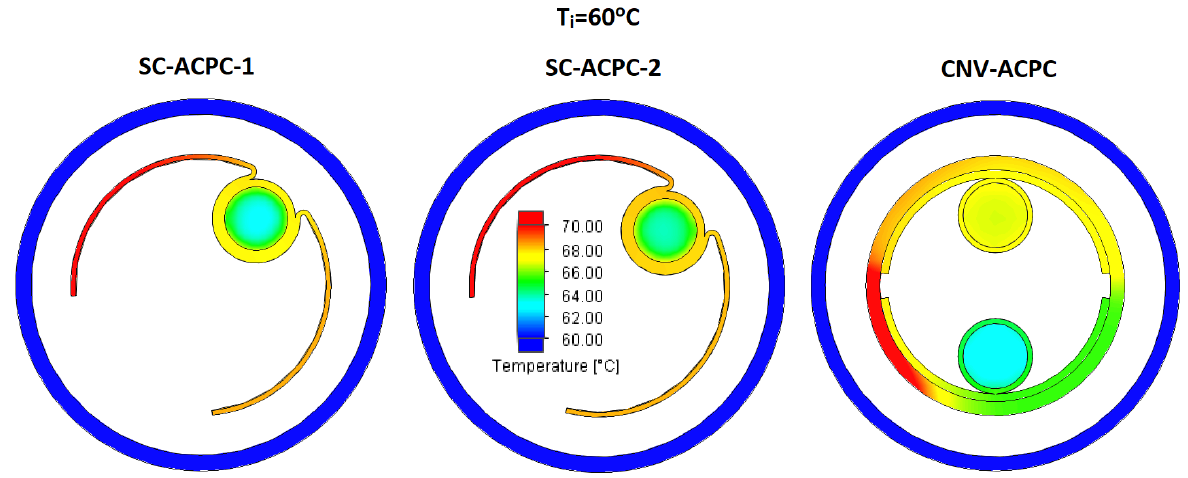
Figure 10. Transversal allocations in the middle of the ACPCs.